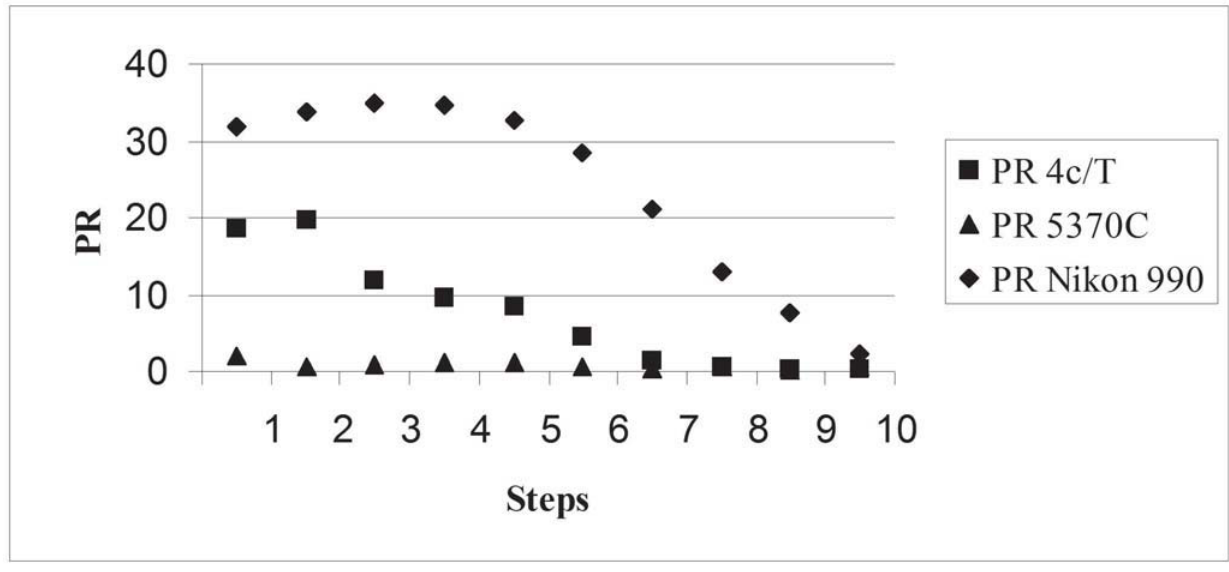
FIGURE 1- Pixel value Reproducibility (PR) values comparison for all TABLE 3- Pixel values (PV1 to PV10) of each step, mean (M) and PR obtained for the Nikon Coolpix 990 digital camera